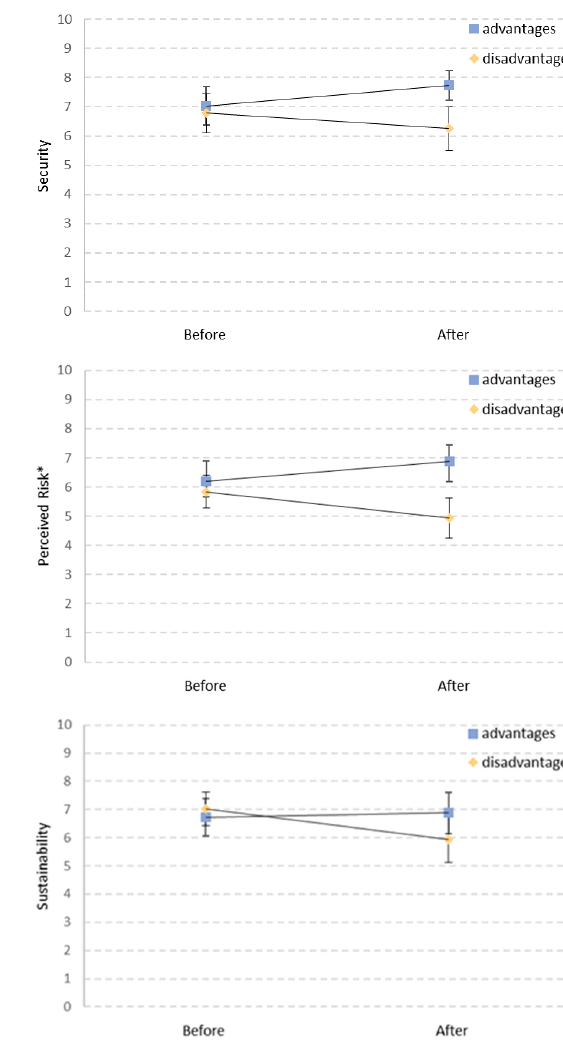
Figure 1. Changes in attitudes after exposure to the informational videos (vertical lines representing confidence intervals) * reverse coded. Table 2. Intergroup comparisons before and after the